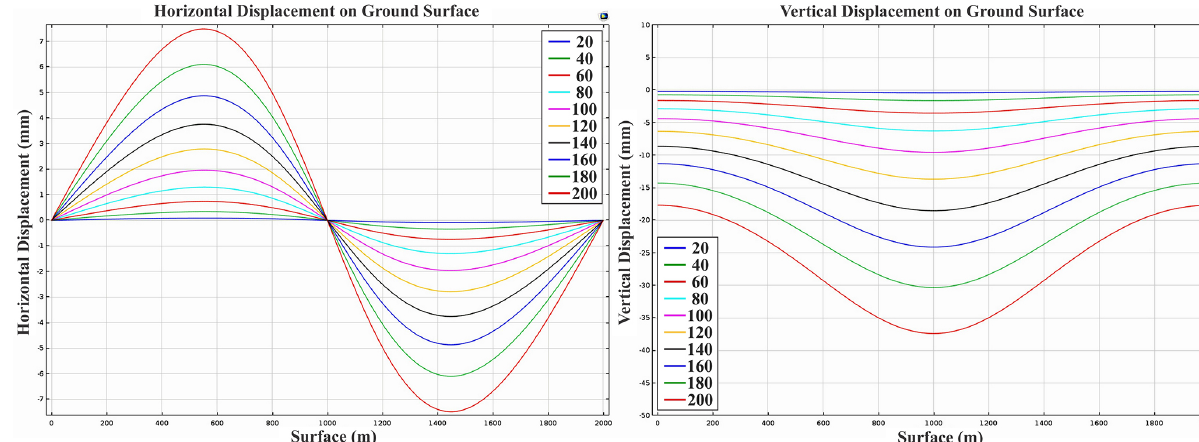
Figure 11. Horizontal and Vertical displacement of surface induced by a deep seated cavity.